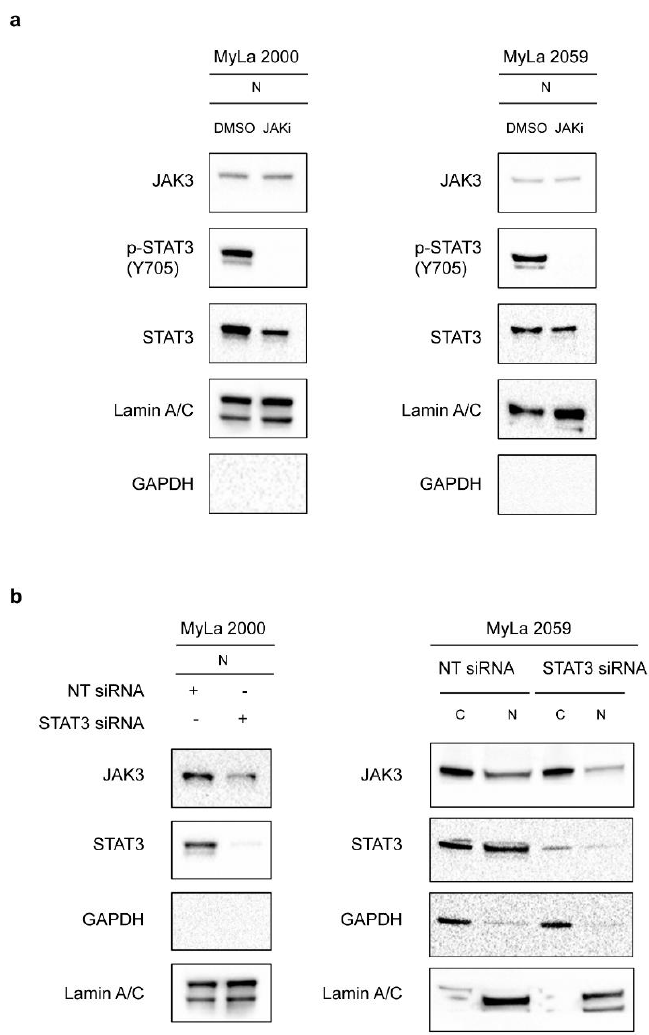
Figure 3. Nuclear localization of JAK3 is independent of its kinase activity and only partly dependent on STAT3. ( a ) Immunoblot shows JAK3 expression in the nuclear extracts (N) of MyLa 2000 (left) and MyLa 2059 (right) after 24 h of treatment with 50 µ M JAK inhibitor, Tofacitinib citrate (CP-690550-10). DMSO is used as a control. JAKi–JAK inhibitor, Tofacitinib citrate (CP-690550-10). ( b ) Immunoblots of cytoplasmic (C) and/or nuclear (N) lysates shows JAK3 expression in control (NT siRNA) and STAT3 transiently knocked down cells (STAT3 siRNA) in MyLa 2000 (left) and MyLa 2059 (right) after 48 h.